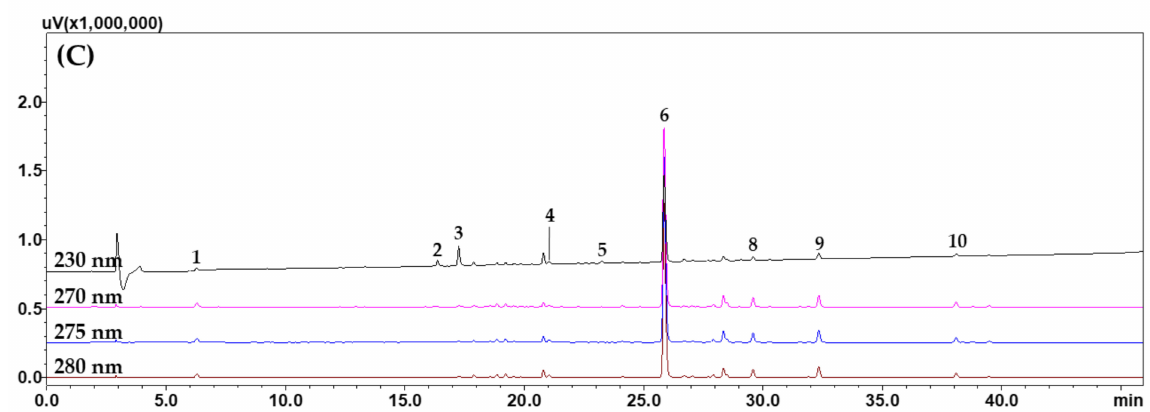
Figure 1. Representative HPLC chromatograms of ( A ) standard solution with 10 marker compounds, ( B ) DSHT sample manufactured by KIOM, and ( C ) commercial DSHT sample distributed and manufactured by a Korean pharmaceutical company. The peaks are gallic acid ( 1 ), albiflorin ( 2 ), paeoniflorin ( 3 ), naringin ( 4 ), benzoic acid ( 5 ), baicalin ( 6 ), poncirin ( 7 ), wogonoside ( 8 ), baicalein ( 9 ), and wogonin ( 10 ).